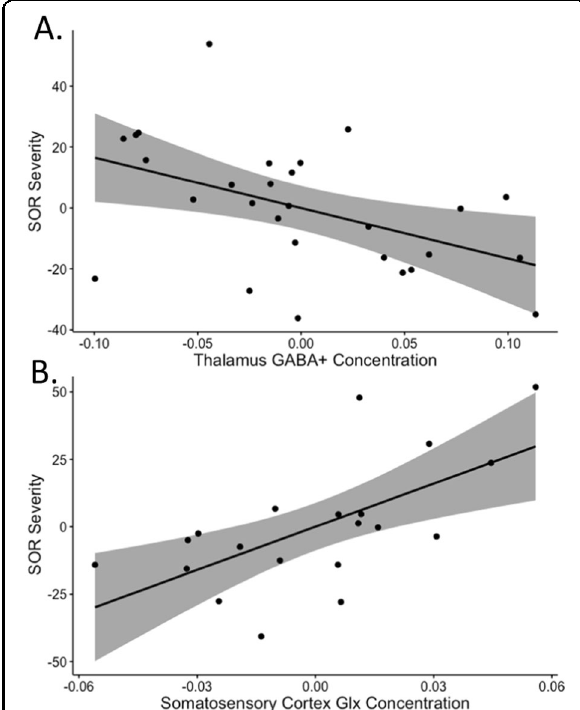
Fig. 1 Relationship between Sensory Over-Responsivity Severity and Neurometabolites in ASD Youth. SOR severity scores are signi fi cantly correlated with: A Thalamus GABA + /Cr ( r = − 0.48, p < 0.05, n = 28; plot of partial regression corrected for SCARED); and, B SSC Glx/Cr ( r = 0.68, p < 0.01, n = 20; plot of partial regression corrected for SSC voxel tissue fraction and